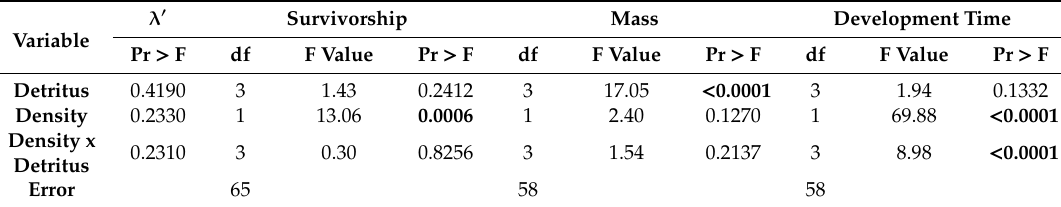
Figure 1. Relationship between number of eggs and wing length for C. pipiens. Table 2. Results of randomization tests for λ ’, and linear models for female survivorship (arcsine square-root transformed), mean female mass, and mean female development time for C. pipiens . Effects significant at experimentwise α = 0.05 (sequential Bonferroni) are shown in bold. Models included block (df = 3).